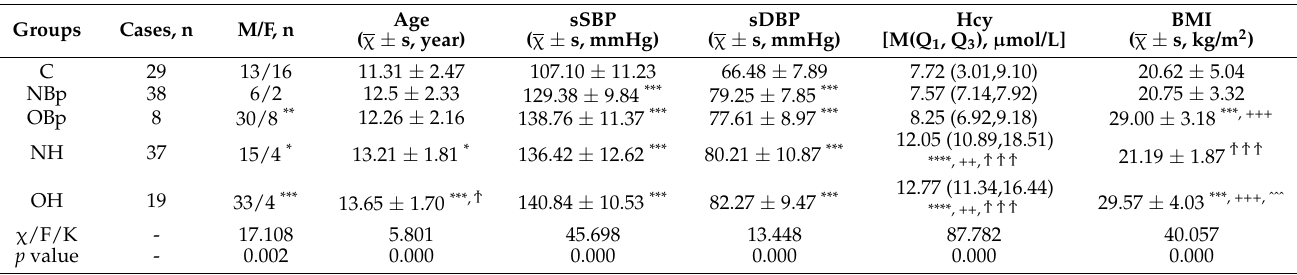
Table 1. Description of basic information of all children.